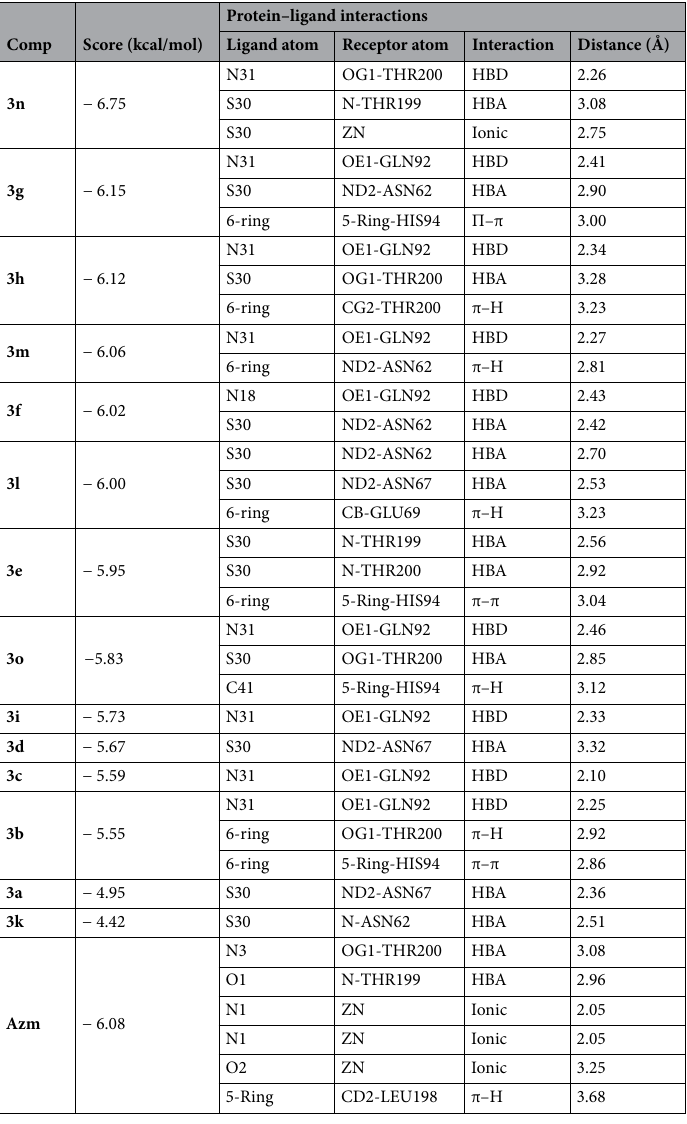
Table 2. Molecular docking results of active compounds against b CA-II. Azm acetazolamide, HBA hydrogen bond acceptor, HBD hydrogen bond